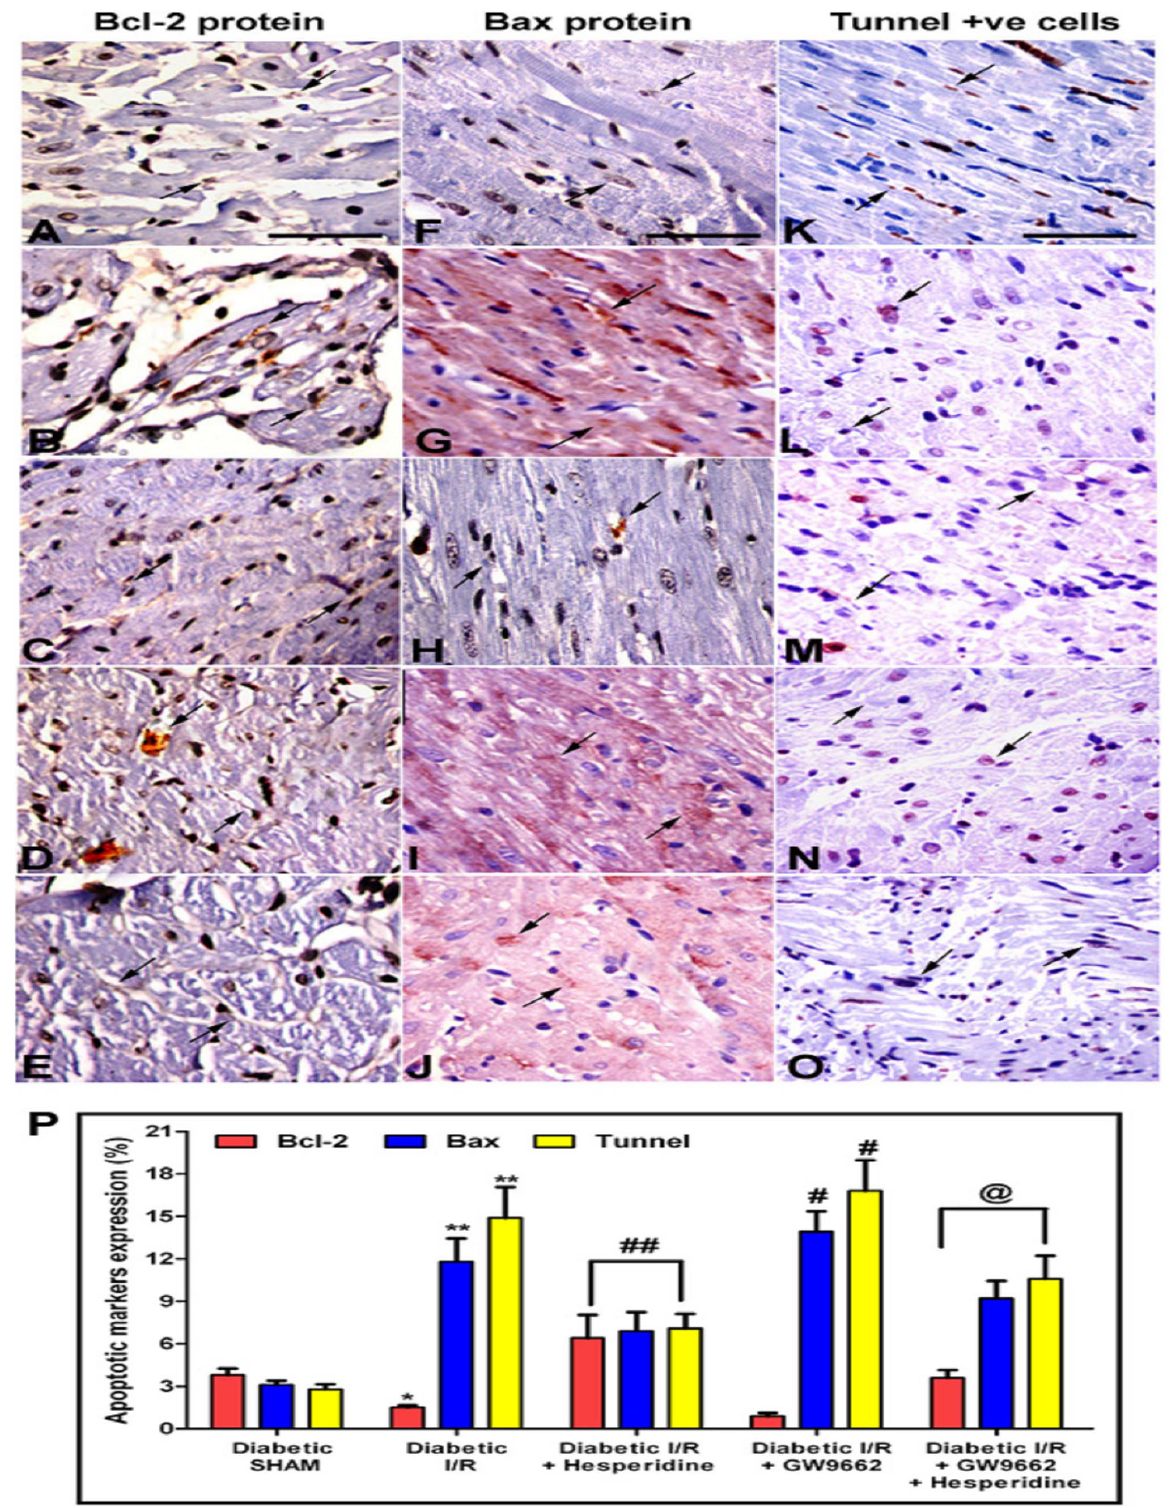
Figure 5. Photomicrograph of myocardial tissue sections showing Bcl-2 (A–E), Bax proteins expression (F–J) and TUNEL-positive cells (K–O). Apoptotic nuclei are indicated by arrows in panels ( 6 400). (A, F and K) represents Diabetic sham rats treated with vehicles, (B, G and L) diabetic ischaemia/reperfusion (I/R) rats treated with vehicles, (C, H and M) diabetic I/R rats treated with hesperidin, (D, I and N) diabetic I/R rats treated with GW9662 and (E, J and O) diabetic I/R rats treated with GW9662 and hesperidin. (P) represents the quantitative analysis of the Bcl-2, Bax proteins and TUNEL-positive cells in the different groups. Data are expressed as the mean 6 standard error (n=6). *p , 0.05, *p , 0.001 vs diabetic SHAM; # p , 0.05, ## p , 0.001 vs Diabetic I/R group; @p , 0.01 vs Diabetic I/R + hesperidin. doi:10.1371/journal.pone.0111212.g005 PLOS ONE |